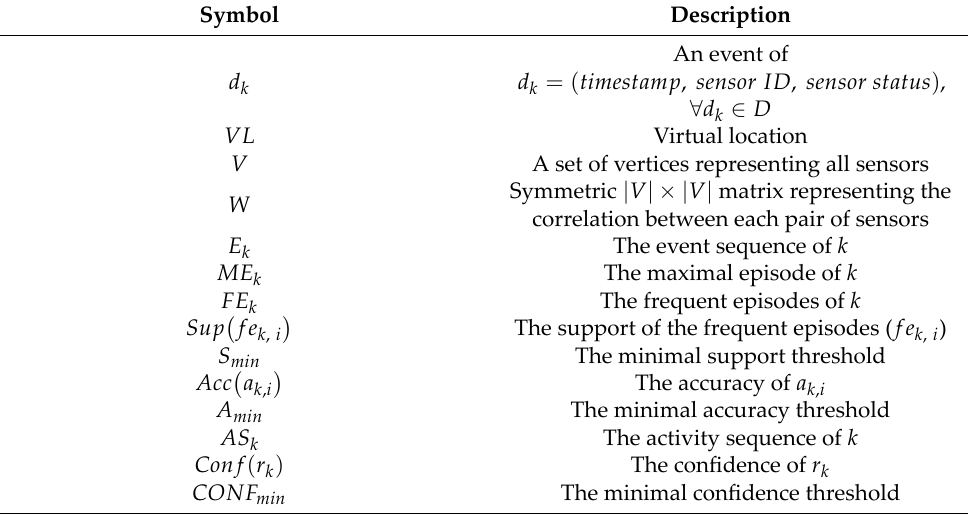
Figure 1. System architecture of the proposed method for smart home applications. Table 1. Main notations used throughout this